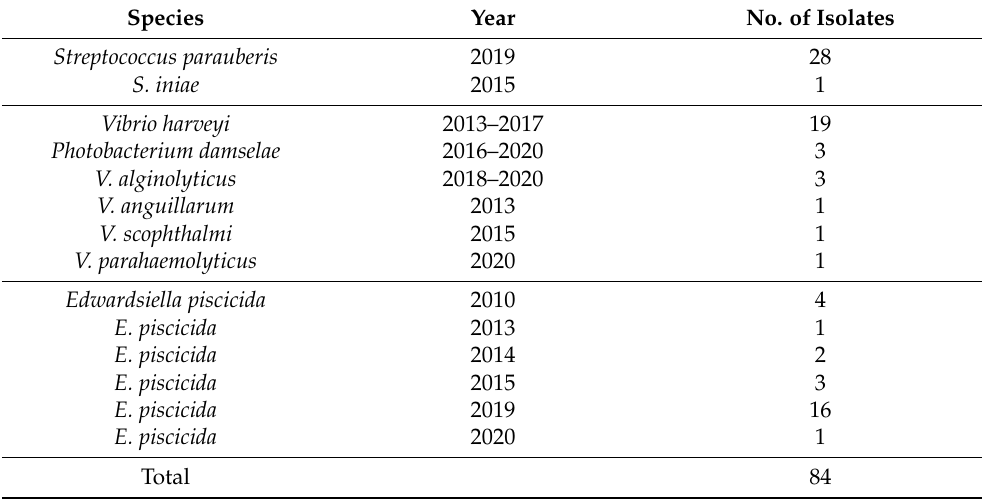
Table 2. List of bacteria isolated from olive flounder in Jeju. Species Year No. of